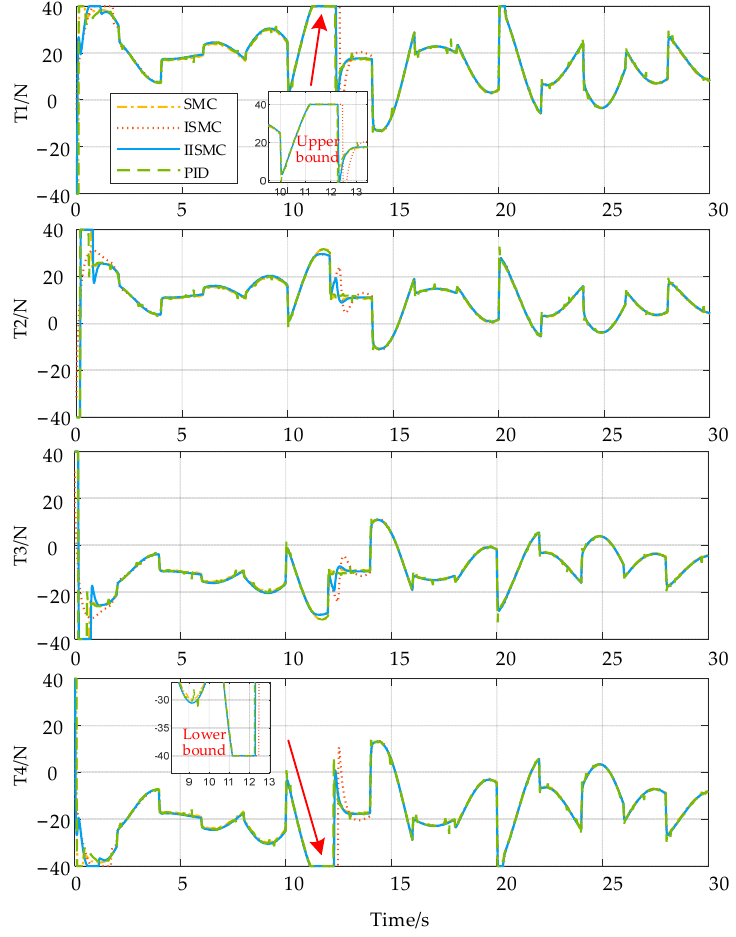
Figure 15. The thrust curve of the four heave thrusters in Scene 3.